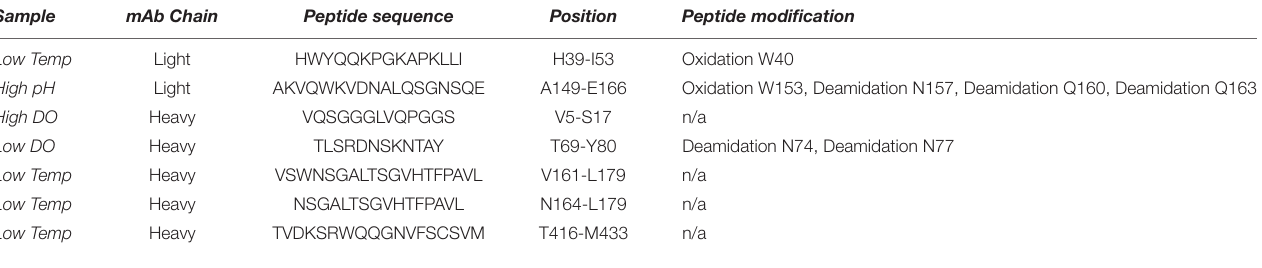
TABLE 2 | Peptides displaying altered deuterium uptake compared to standard mAb samples analyzed by HDX-MS and related peptide modifications identified by peptide mapping.